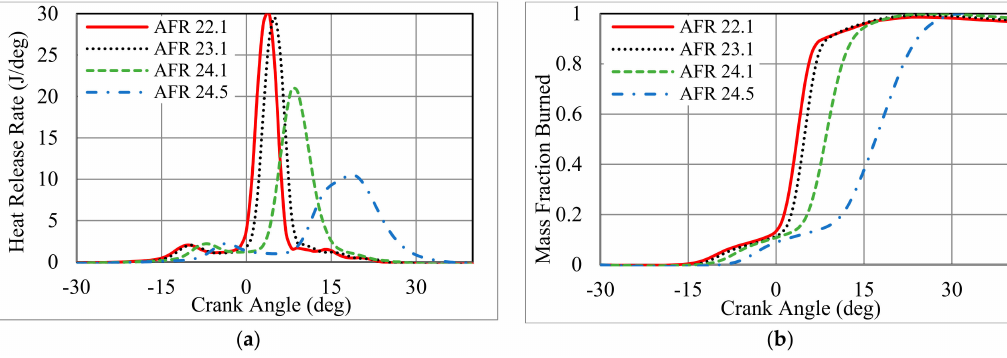
Figure 6. Combustion characteristics with various AFR s: ( a ) heat release rate (HRR); and ( b ) mass fraction burned ( MFB